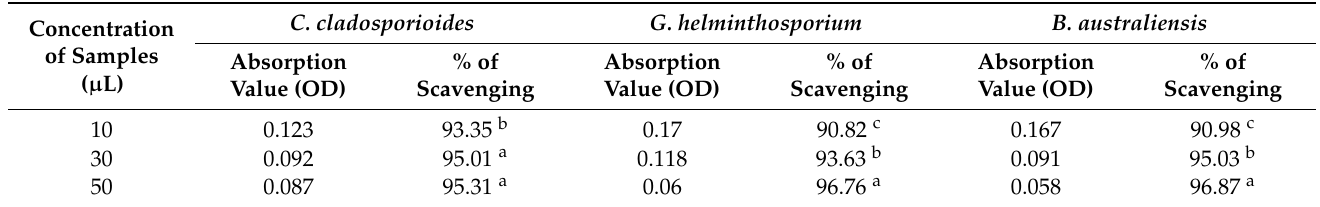
Table 6. H 2 O 2 antioxidant scavenging activity of the ethyl acetate (extracellular) extract of Cladospo- rium cladosporioides, Graminicolous helminthosporium , and Bipolaris australiensis. Data are represented as means ± SD of three replicates. Numbers within a column followed by the same letters are not significantly different at p ≤ 0.05.